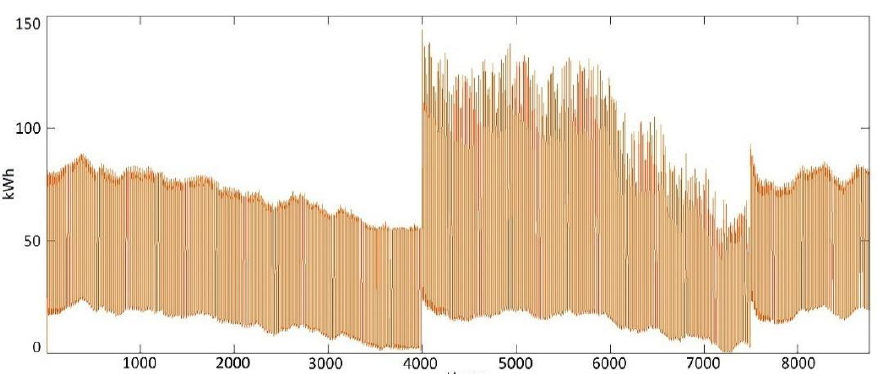
Figure 15. Hourly absorbed electric power VRF.